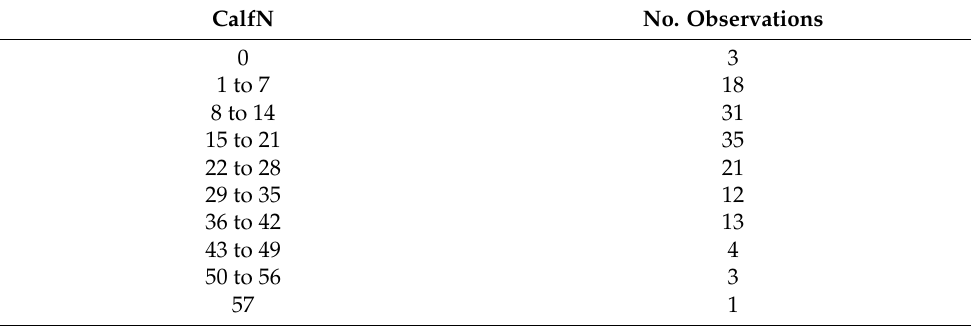
Table 3. Distribution of number of calves (CalfN) by bull within pasture and year.